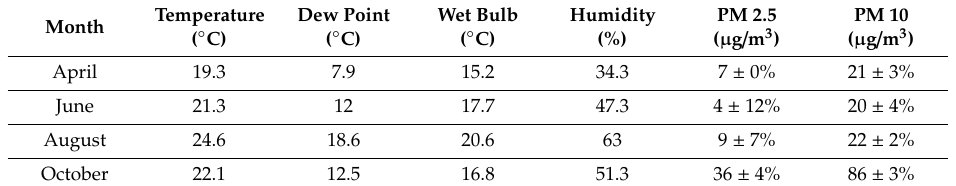
Table 2. Physico-chemical conditions in the Rotunda of Sts. Felix and Adauctus. The PM abbreviation means particulate matter with an aerodynamic diameter grain size expressed in µ